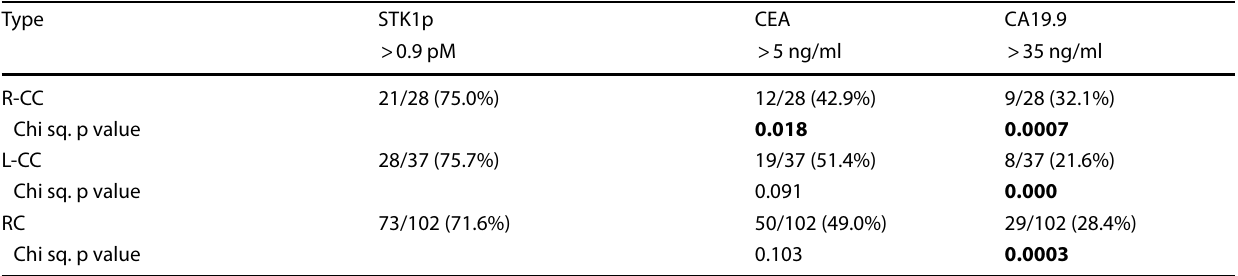
Table 3 The elevated STK1p value at the end of the 108-month follow-up of the R-CC, L-CC and RC patients correlated with mortality. The p values of CEA and CA19.9 are in relation to STK1p, for percentage values or the number of the patients. Chi-sq.: chi-square test